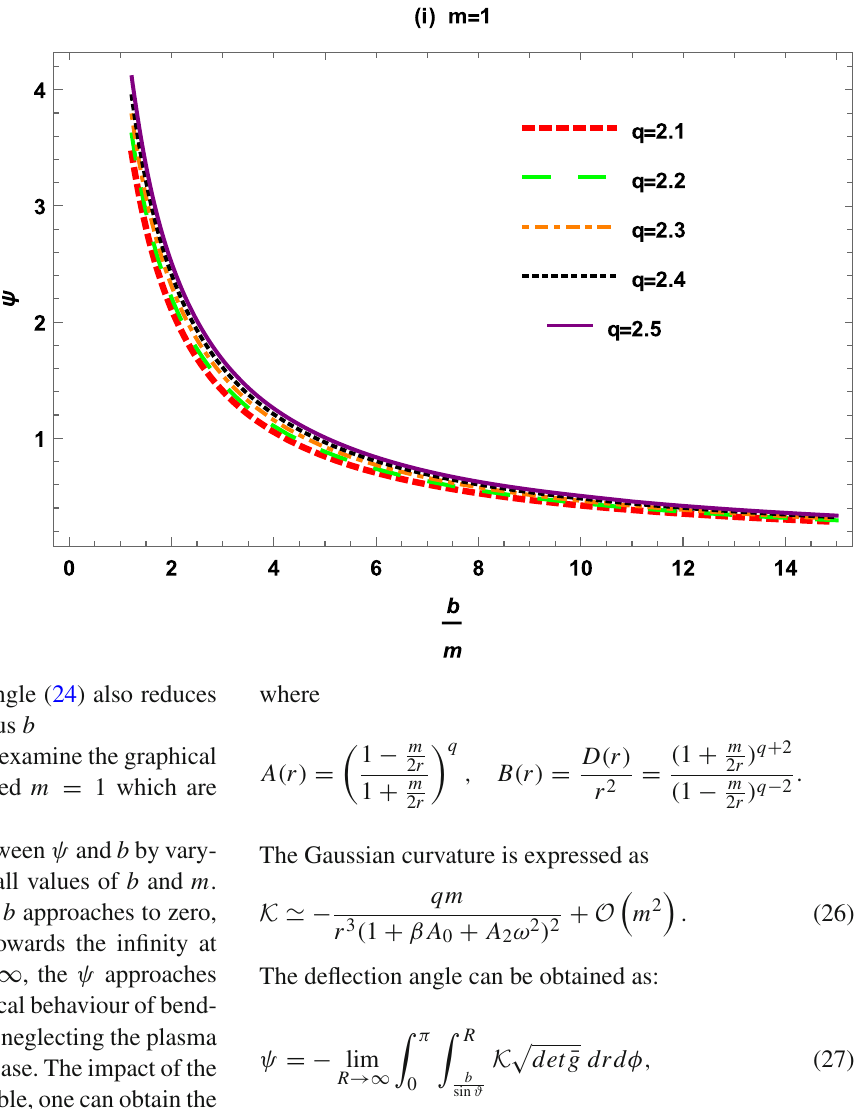
Fig. 1 Plot of ψ versus